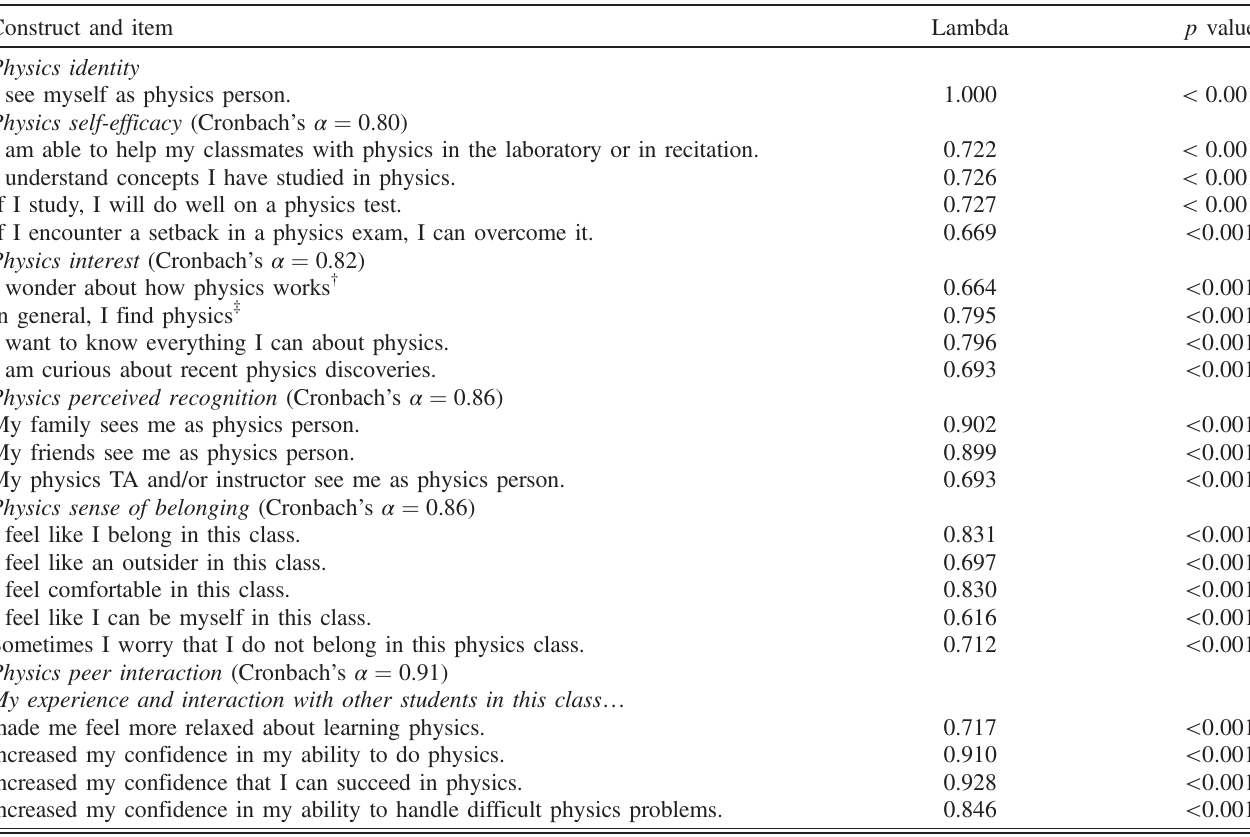
TABLE I. Survey items for each of the motivational scales. The Cronbach ’ s alpha and CFA item loadings (Lambda and p values of the significance test for each item loading) shown here were calculated with the postdata. † The response options for this question are “ Never, once a month, once a week, every day ” . ‡ The response options for this question are “ Very boring, boring, interesting, very interesting.